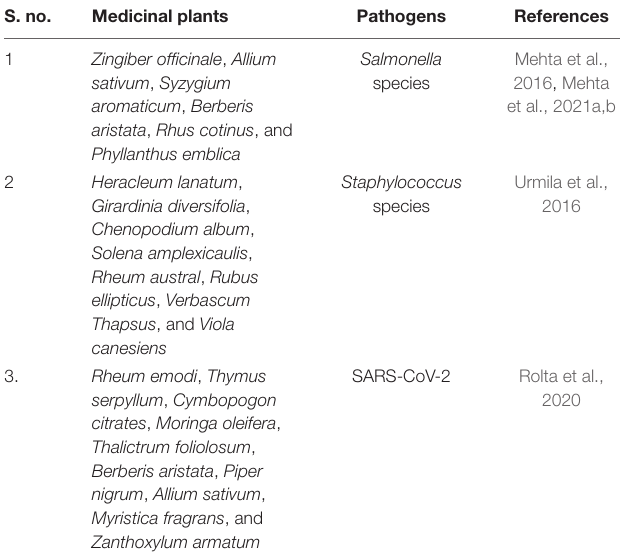
TABLE 1 | Medicinal plants reported having antimicrobial activity including anti-SARS-CoV-2 activity. S.